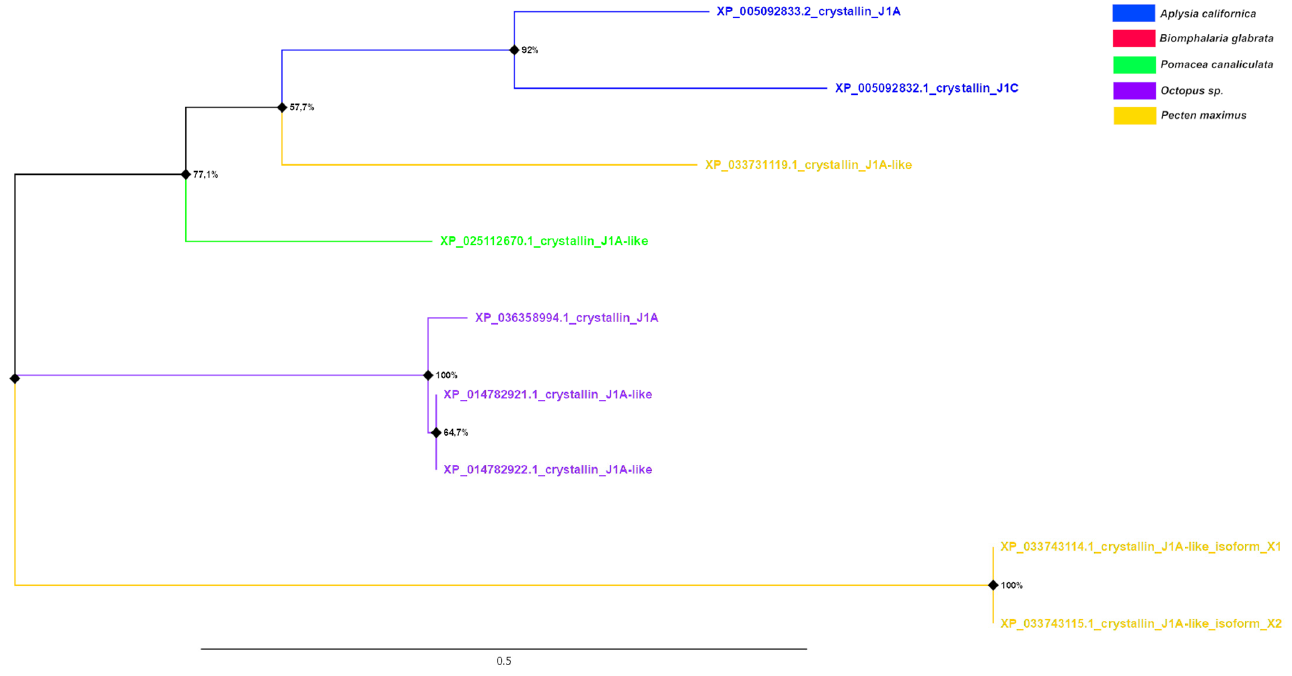
Figure 6. Phylogenetic tree of J1 -crystallins of molluscs.